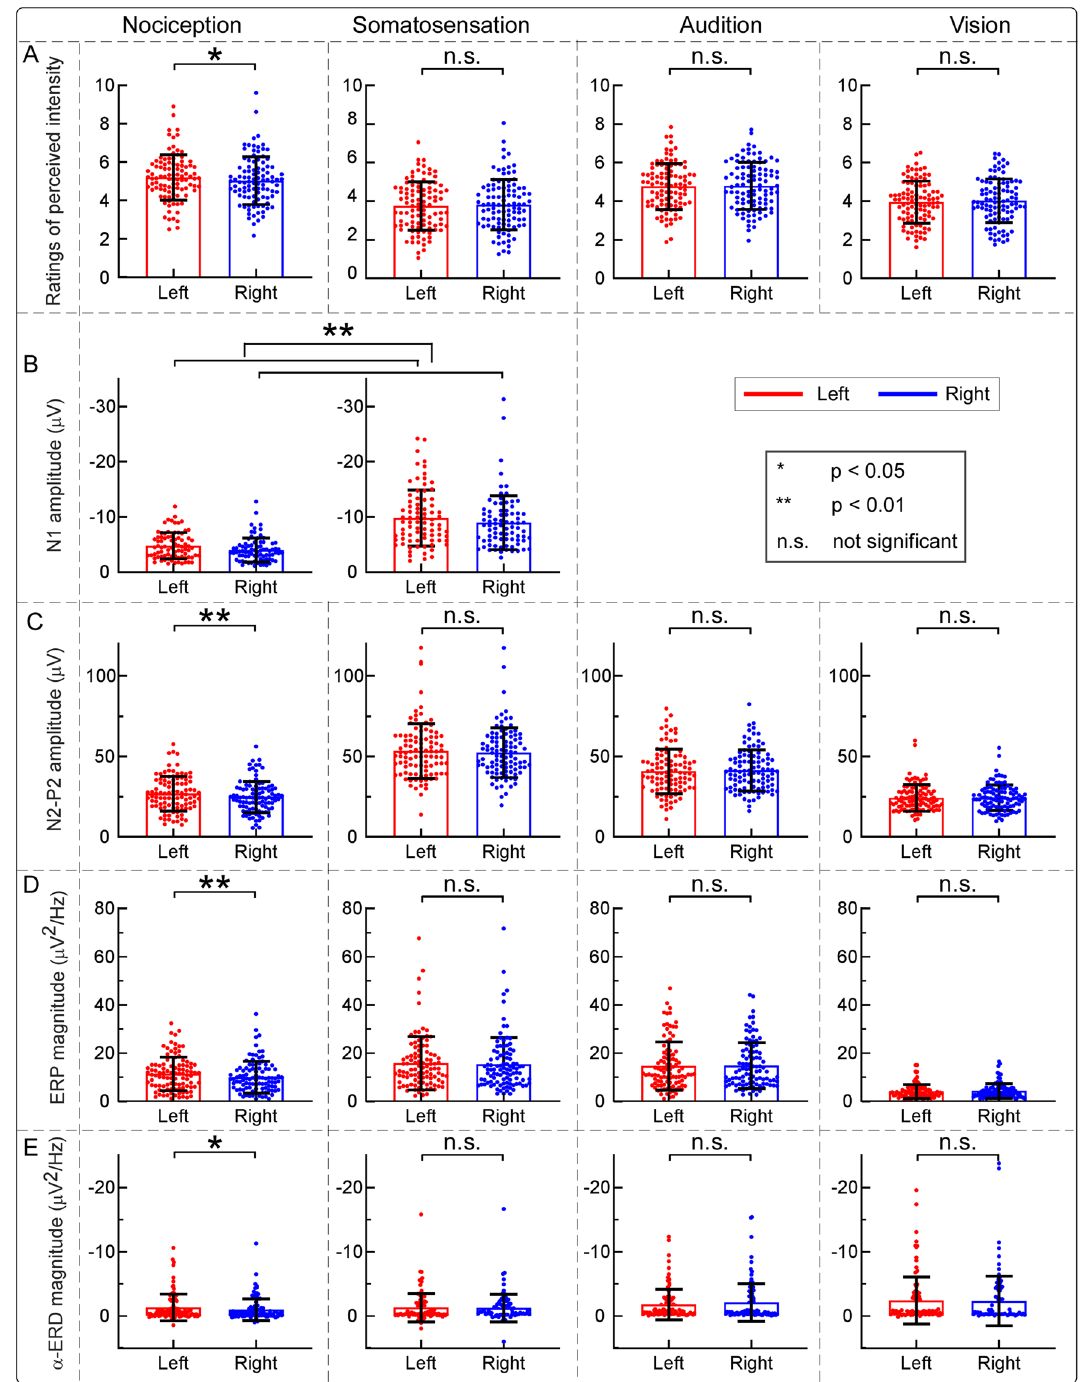
Figure 1. Effects of sensory modality and stimulated side on perceived intensities and electrophysiological responses elicited by transient stimuli. Perceived intensities, N1 amplitudes, N2–P2 amplitudes, ‘ERP’ magnitudes, and ‘α-ERD’ magnitudes elicited by nociceptive somatosensory, non-nociceptive somatosensory, auditory, and visual stimuli delivered to the left (red color) and right (blue color) sides are displayed from ( A – E ). Error bars represent SD (standard deviation) across subjects. Each dot represents the data from a single subject. Perceived intensities and almost all brain responses (N2–P2 amplitude, ‘ERP’ magnitude, and ‘α-ERD’ magnitude) elicited by nociceptive somatosensory stimuli that were delivered to the left side were significantly larger than those to the right side. In contrast, for non-nociceptive somatosensory, auditory, and visual stimuli, perceived intensities and brain responses were not significantly different between the two